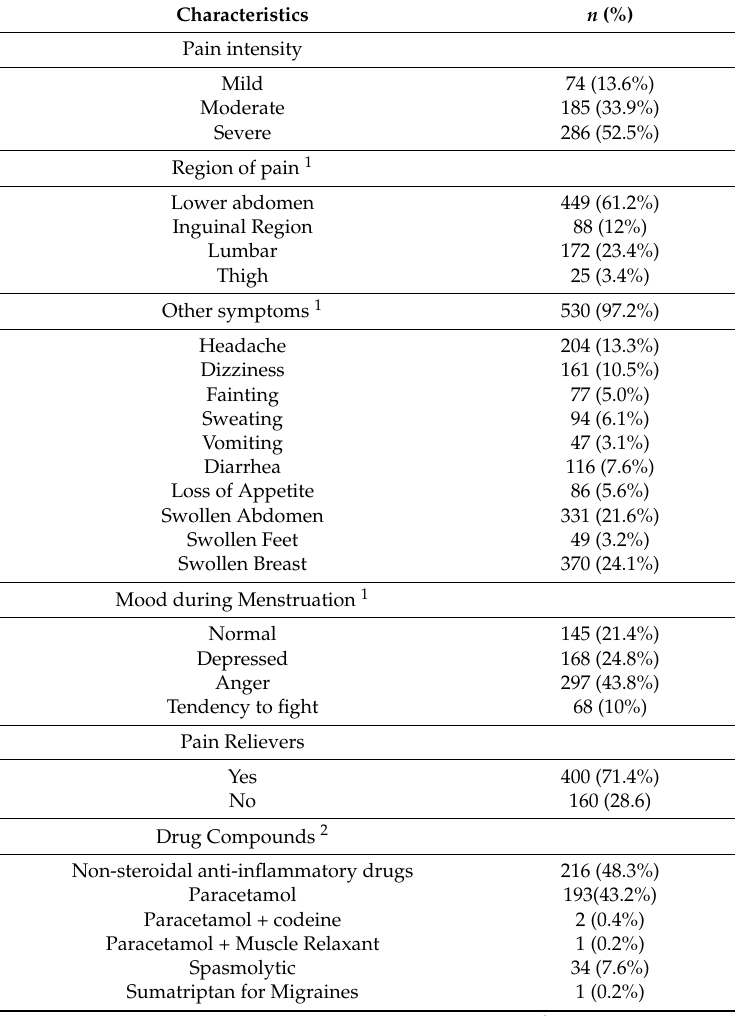
Table 2. Pain Intensity, region of pain, and other menstrual